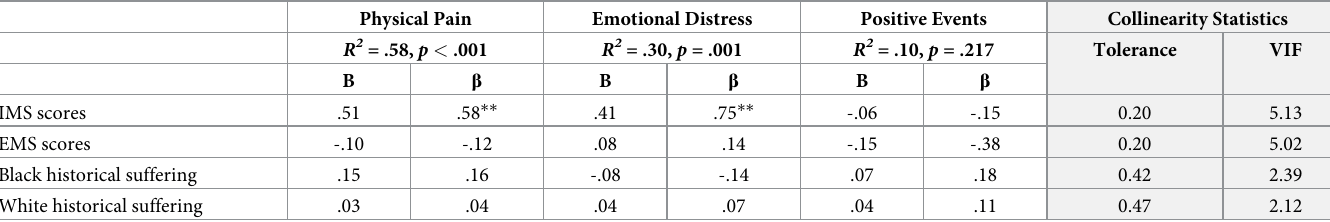
Table 3. Individual difference measures: Simultaneous regressions predicting self-reported empathy for different event